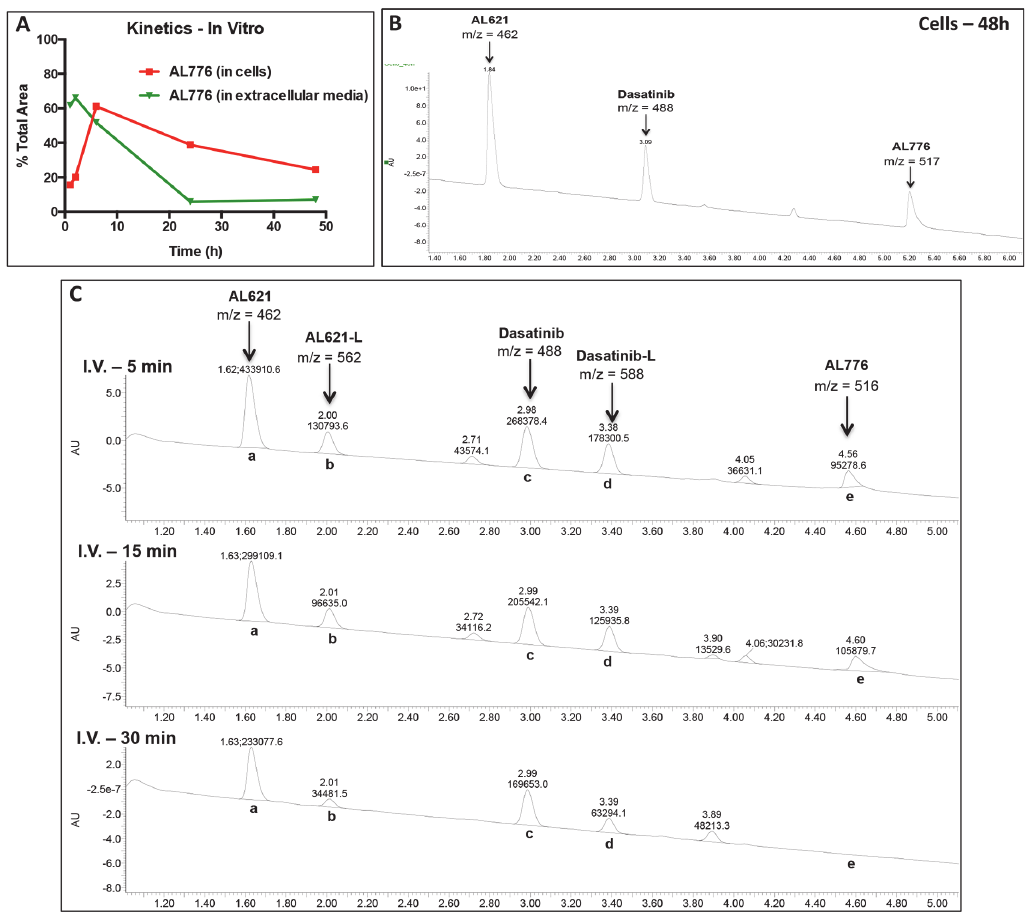
Fig 4. In vitro and in vivo hydrolysis of AL776 using high performance liquid chromatography (HPLC) and mass spectrometry (MS) analyses. ( A ) The kinetics of entry into the cells and degradation of AL776 inside the cells were monitored using HPLC analysis. NIH3T3-Her14 (EGFR transfected) cells were treated with 25 μ M of AL776 for 1h, 2h, 6h, 24h and 48h, after which the cells and the corresponding extracellular media were collected and processed according to the procedure described in the Materials and Method section. The area under the curve (AUC) for the AL776 peak was determined and its percentage compared with all the other peaks was calculated and plotted. ( B ) A representative spectrum obtained from liquid chromatography (LC)-mass spectrometry (MS) analysis in cells treated with AL776 for 48h is shown with m/z = 462 (AL621), m/z = 488 (dasatinib) and m/2z = 517 (AL776). ( C ) The kinetics of AL776 hydrolysis in the plasma of CD-1 mice injected with 80 mg/kg of the drug was monitored 5, 15 and 30 min post-administration. LC-MS chromatograms at different time points with m/z values for intact AL776 and its metabolites are shown: m/z = 462 for AL621, m/z = 562 for AL621-L (succinic acid linked-AL621), m/z = 488 for dasatinib, m/z = 588 for dasatinib-L (succinic acid linked-dasatinib), m/2z = 516 for